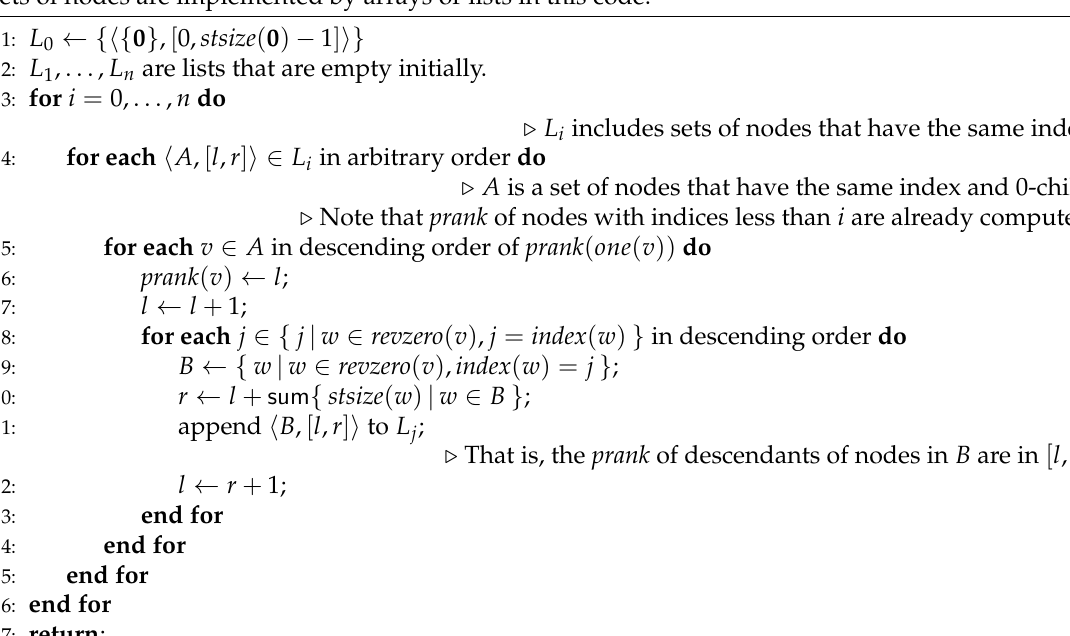
Algorithm 1 Compute_Preorder : Algorithm that computes the preorder rank prank ( v ) of each node v . Sets of nodes are implemented by arrays or lists in this